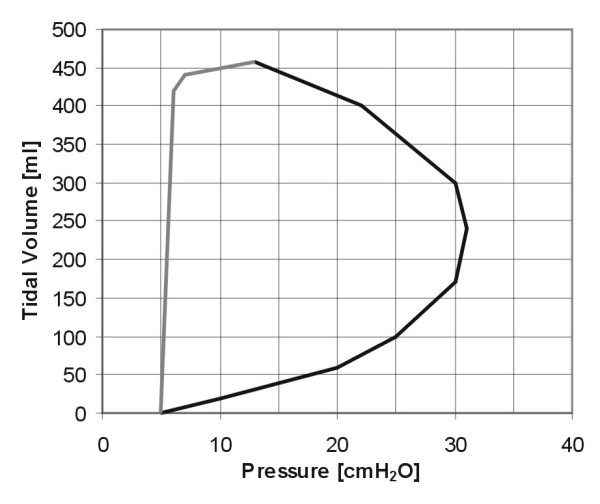
Obstructive disease. i.e. asthma. PV loops produced by model with PEEP at 5 cmH2O and Tidal volume of 450 ml. The plot shows PV curve produced by the model with increased resistance, simulating a flow restricting disease, such as asthma.